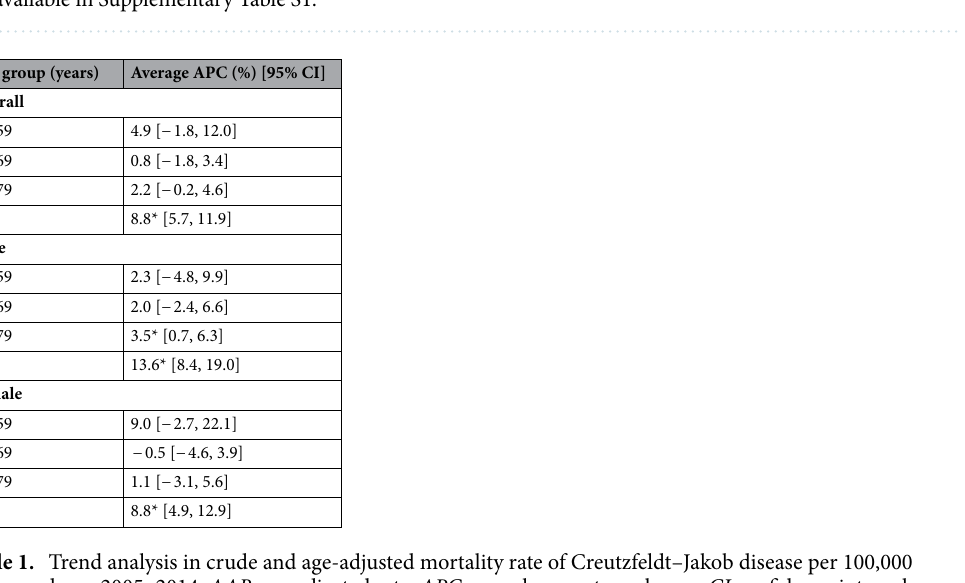
Figure 2. Trends in crude mortality rates (per 1,000,000 population) of Creutzfeldt–Jakob Disease-associated death by age and sex, 2005–2014. The trends in crude mortality rates of CJD-associated deaths in patients over the age of 50 years by 10-year age groups and sex are described. The detailed numerical values for the age groups are available in Supplementary Table S1.